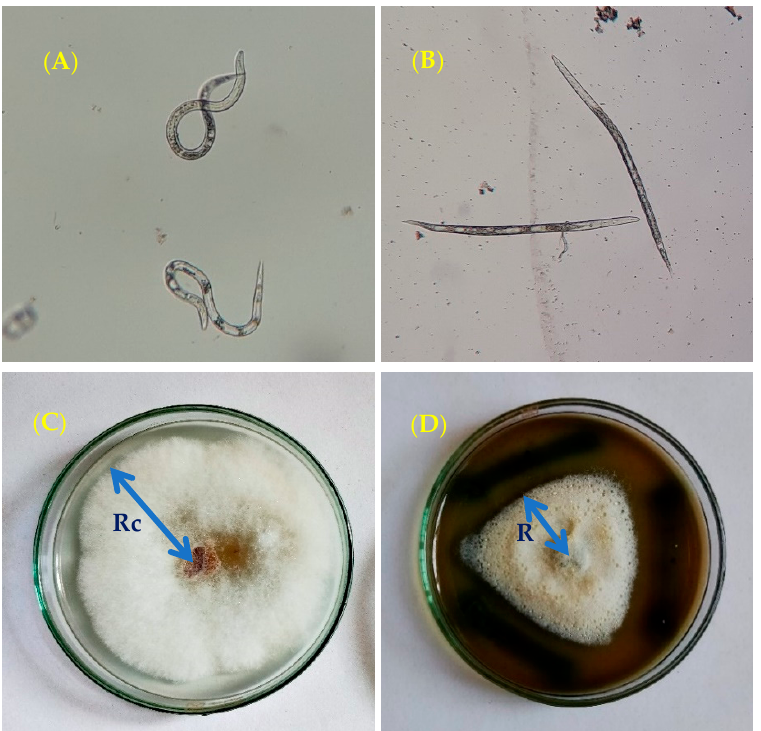
Figure 2. Images of the anti-nematicidal and anti-fungal assays of the rhizobacterial strains. The mobilized J2 coffee nematodes ( A ) became immobilized J2 coffee nematodes ( B ) after 24 h of treatment with rhizobacterial strain. The pathogenic fungus was grown on potato dextrose agar (PDA) ( C ), control dish, and also on PDA treated with a rhizobacterial strain ( D ), experimental dish. After five days of cultivation, the radius (cm) of fungal mycelial spread on the control dish (Rc) and the experimental dish (R) were measured for the calculation of antifungal activity.